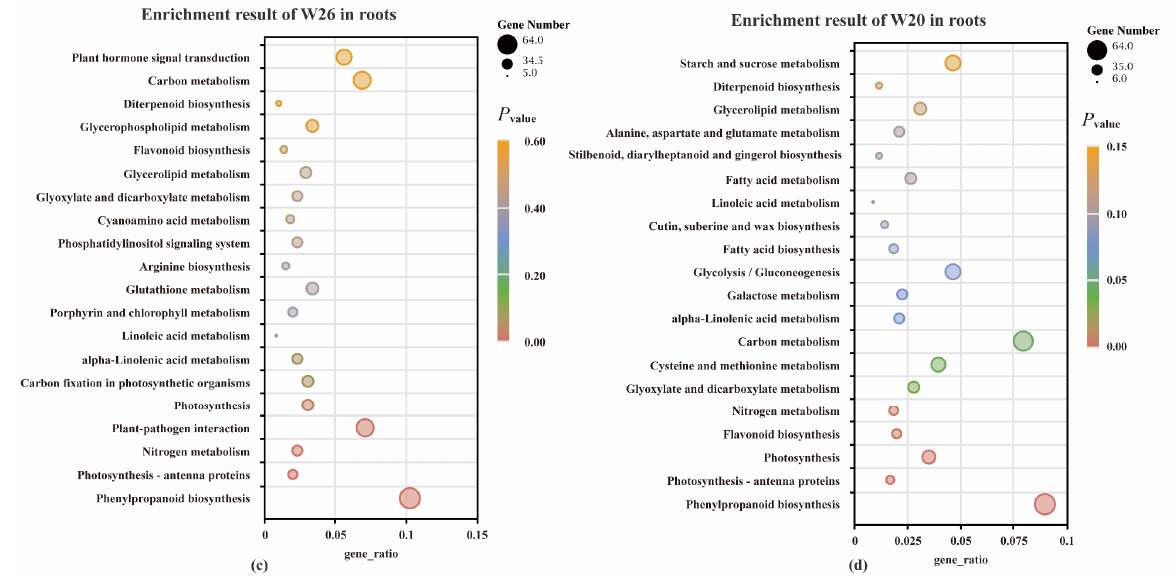
Figure 5. The statistics of KEGG enrichment in leaves and roots of barley. ( a , b ) show the KEGG enrichment results of the differentially expressed genes (DEGs) in W26 and W20 leaves, respectively. ( c , d ) show the KEGG enrichment results of the DEGs in W26 and W20 roots, respectively. The abscissa in the figure is the ratio of the number of DEGs annotated on the KEGG pathway to the total number of DEGs, and the ordinate is the KEGG pathway name. The depth of color represents the degree of enrichment.